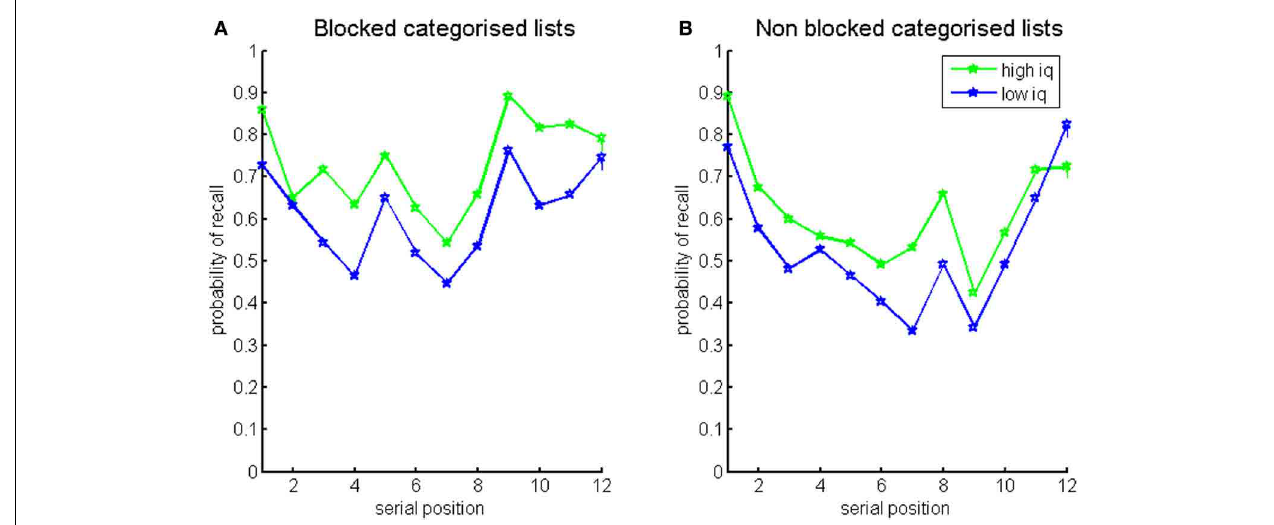
FIGURE 3 | Probabilities of recall for blocked categorized lists (left) and non-blocked categorized lists (right), split by IQ median score (green for higher-IQ individuals, blue for lower-IQ individuals).